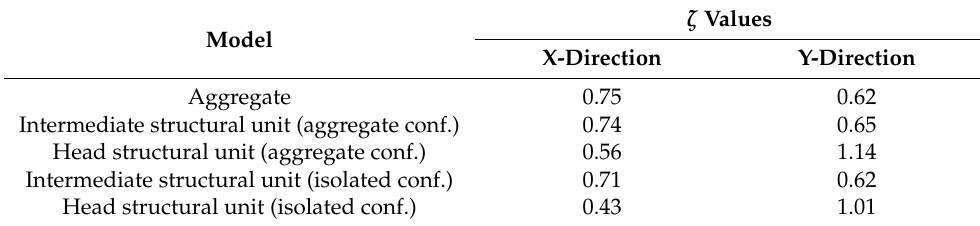
Table 2. Safety index evaluated for each structural configuration examined.